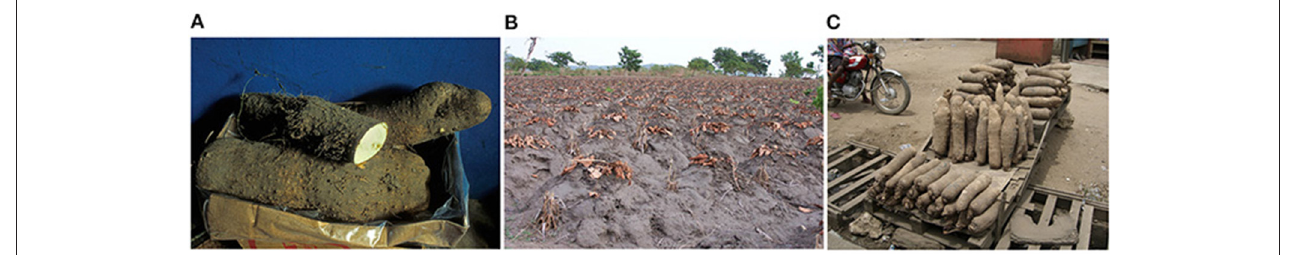
FIGURE 11 | African Yam ( Dioscorea cayenensis-rotundata complex). (A) Sliced yam (Dioscorea sp.) Source: A. Denney. CC BY-NC-SA 2.0. (B) Traditional yam mound cultivation technique where mounds are covered with mulch. Source: IITA. CC BY-NC 2.0. (C) Harvested yams brought to a market (see motorbike for scale). Source: L. Kreusel. CC BY-NC